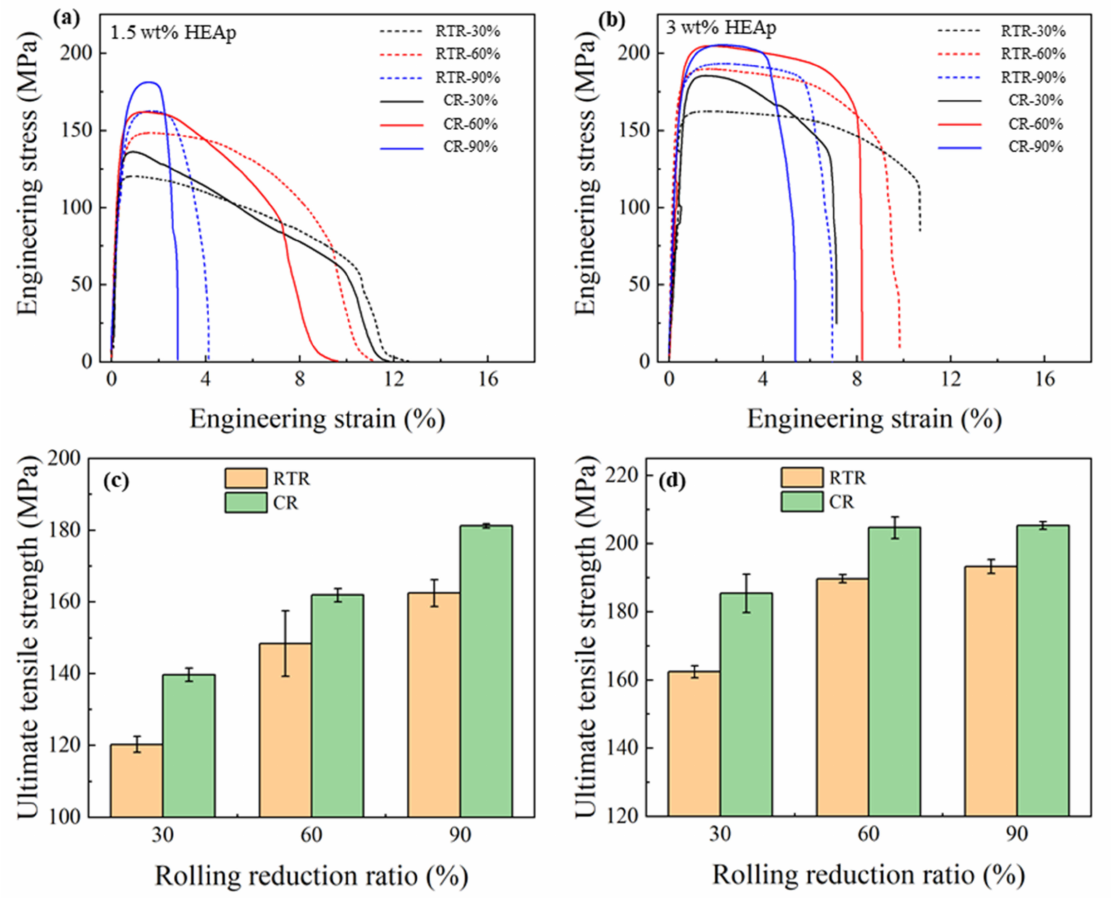
Figure 5. Tensile stress–strain curves of the AMCs after RTR and CR with ( a ) 1.5 wt% HEAp and ( b ) 3 wt% HEAp. UTS histogram of ( c ) 1.5 wt% HEAp and ( d ) 3 wt%